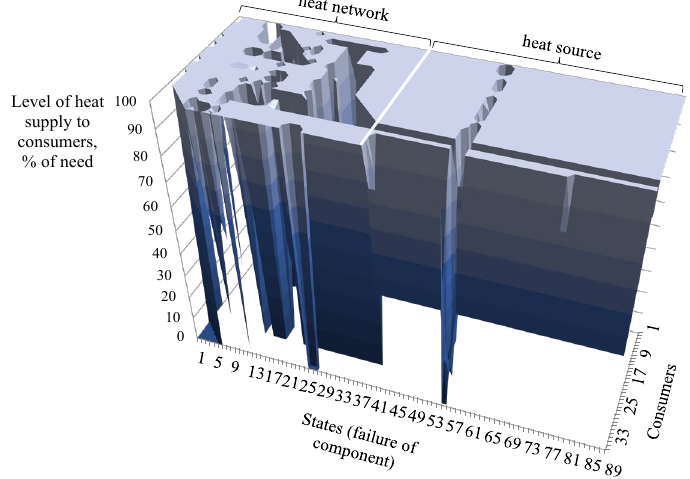
Fig. 8. Levels of heat supply to consumers in case of failures of components of DHS subsystems (HS and HN). On the vertical axis of this diagram, the relative level of heat supply to consumers is set in percent (%) of the need (required) value. On the horizontal axes, numbers of DHS states (corresponding to failures of HS and HN components) and numbers of consumers are set. The plane of 100 % heat supply has “dips” in the field of interruptions of the required heating. It can be seen from the figure that a large proportion of interruptions are related to failures